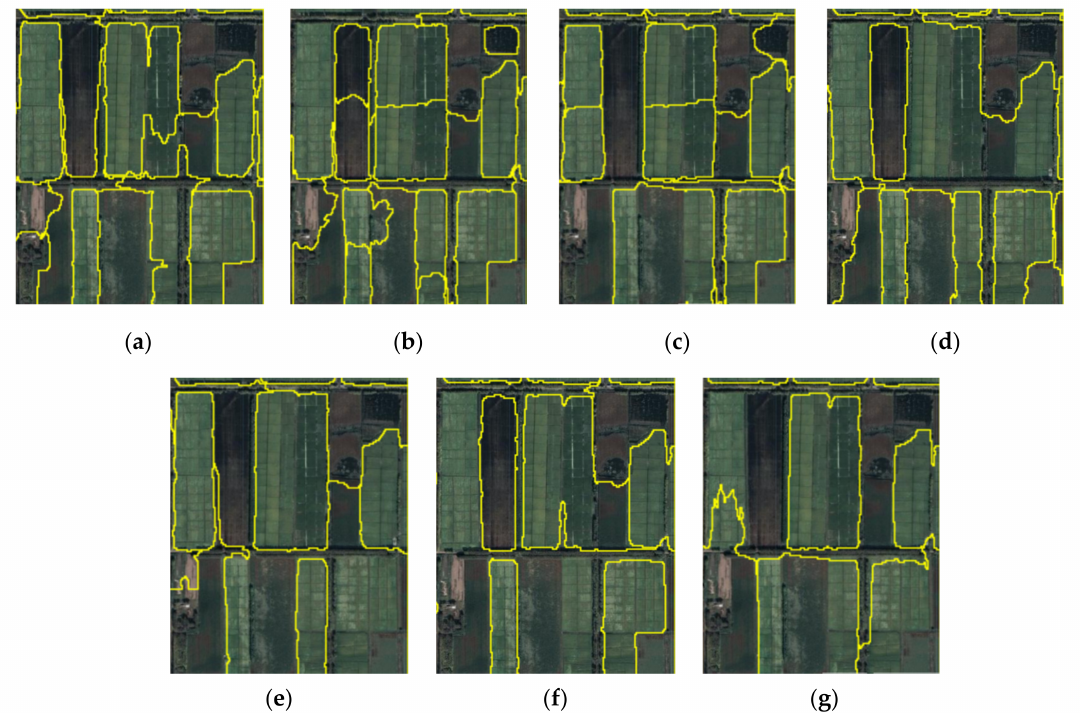
Figure 6. Results of segmentation under different scales: ( a ) scale = 52, ( b ) scale = 55, ( c ) scale = 61,